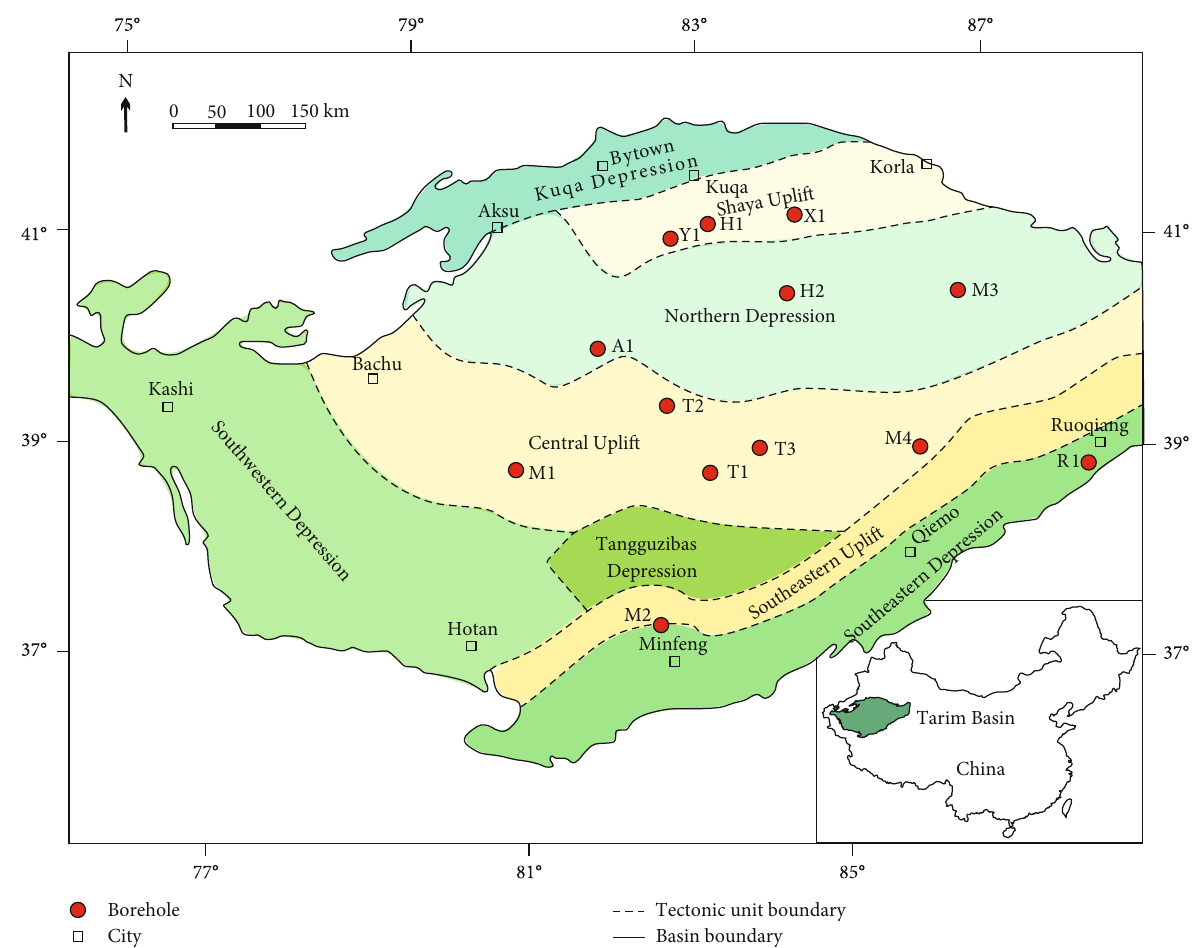
Figure 5: Sampling positions in the Tarim Basin, Northwest